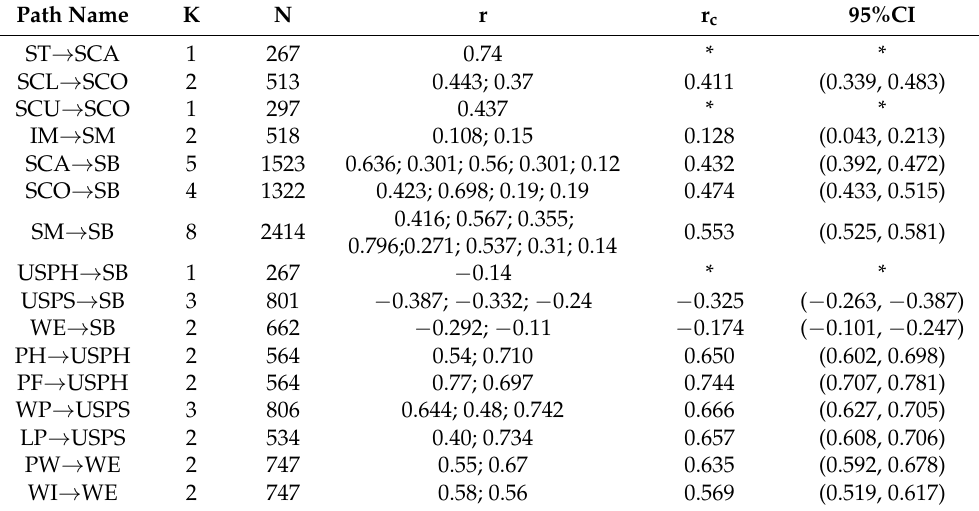
Table 1. Combined results of each correlation coefficients.